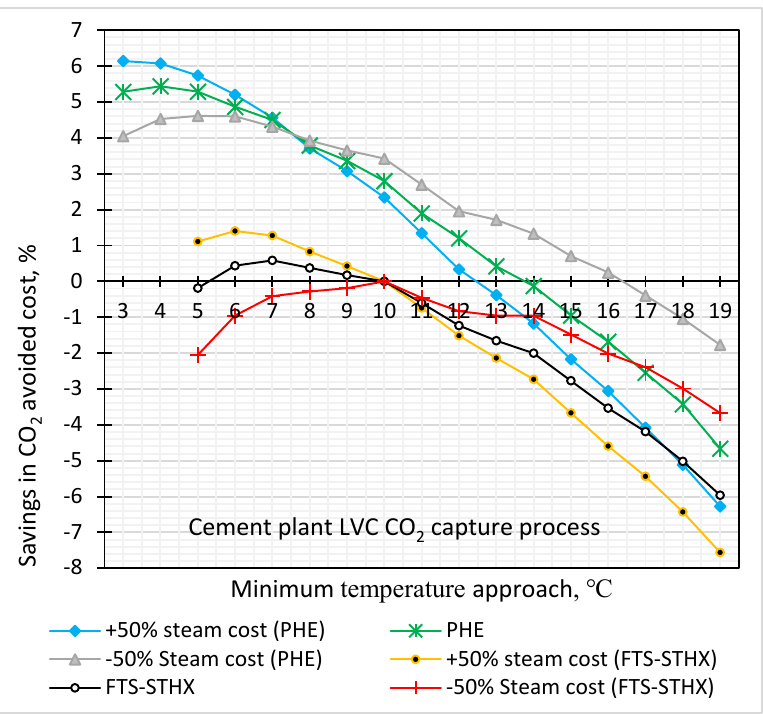
Figure 20. Sensitivity analysis of steam cost on the energy and heat exchanger costs trade–off analyses at different ∆ T min for different heat exchanger types in a standard CO 2 capture from cement flue gas.